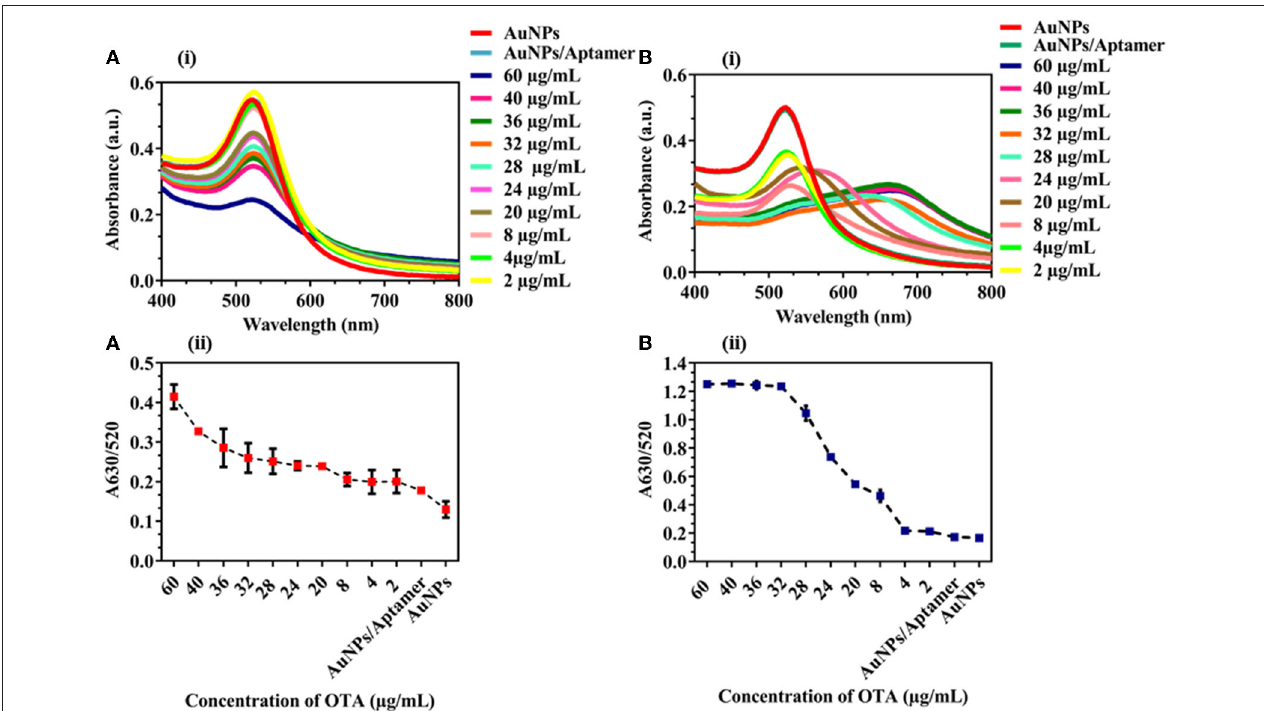
FIGURE 4 | Detection of OTA in corn flour and groundnut: (A) (i) and (ii) UV-vis spectra and A 630 / 520 nm absorbance peak ratio of corn flour sample spiked with OTA (B) (i) and (ii) UV-vis spectra and A 630 / 520 nm absorbance peak ratio of groundnut samples spiked with OTA. We observed an increased aggregation tendency with an increase in the concentration of OTA in corn flour and